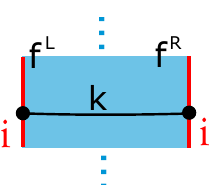
Figure 10 . Hilbert space of JT gravity with two Schwarzian (holographic) boundaries. In path integral language, the degrees of freedom are given by separate left and right reparametrizations f L ( τ ) and f R ( τ